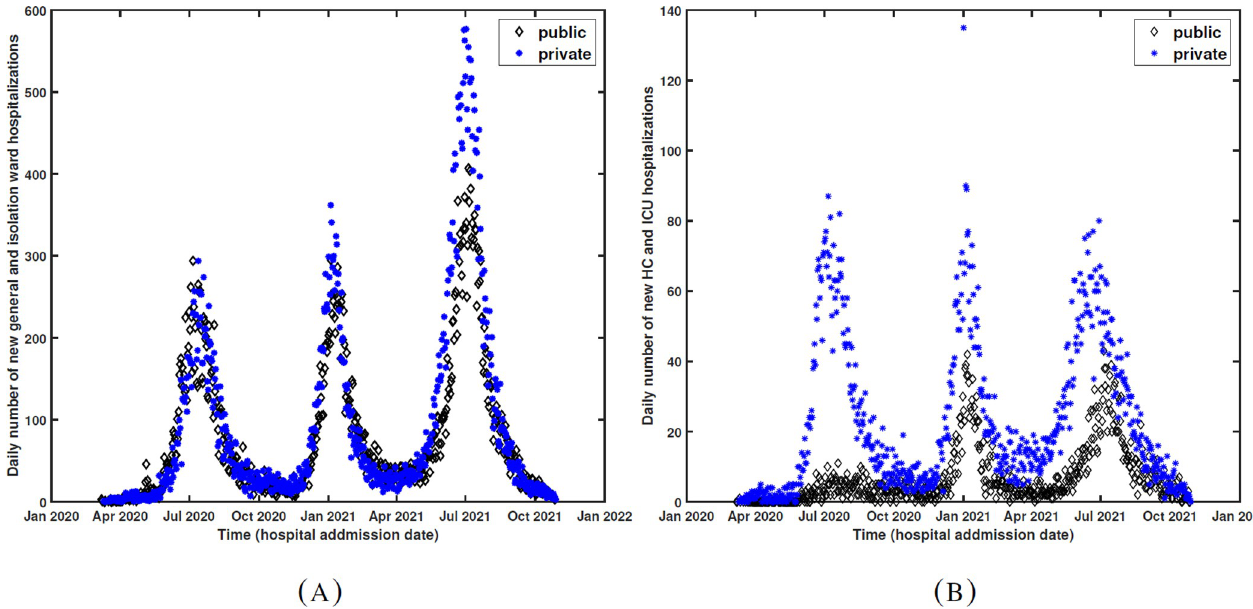
Fig 5. (A) Daily number of general/isolation ward hospitalizations in public (black diamonds) and private (blue stars) sectors (B) Daily number of HC/ICU hospitalizations in public (black diamonds) and private (blue stars)